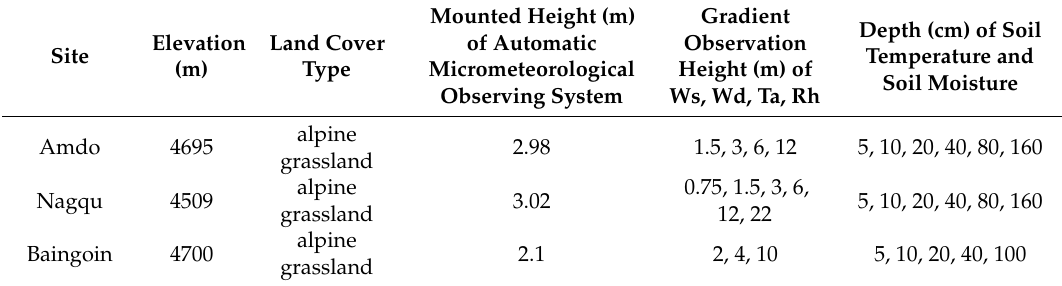
Table 2. Geographical conditions and measurements at the four sites used in this